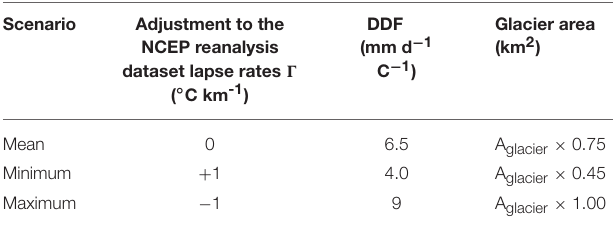
TABLE 2 | Summary of parameters used in the degree-day model to find upper and lower bounds and mean meltwater flux.